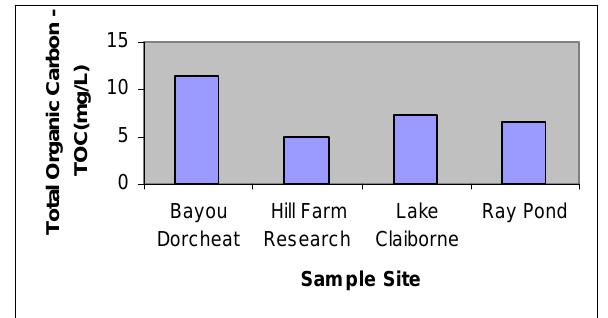
Figure 3: Mean values of total organic carbon TOC (mg/L) at each sample site